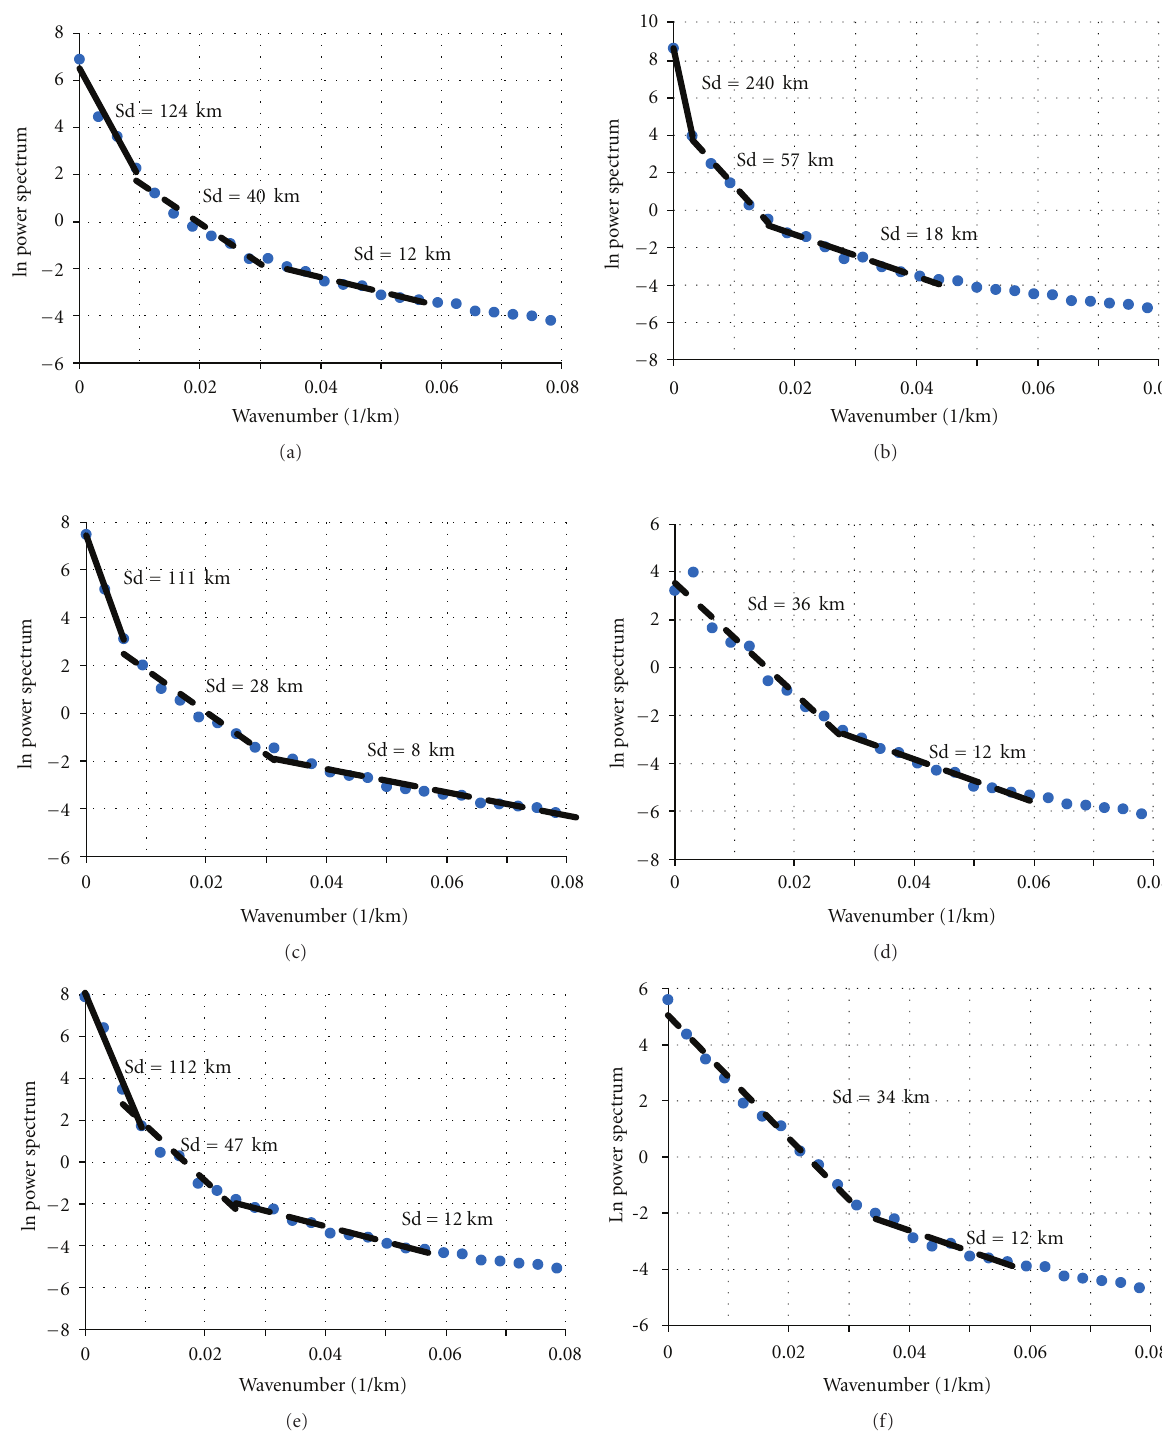
Figure 6: Results for the power spectrum analysis of the Bouguer gravity field using 2D fast Fourier transform. Black lines represent the trends of the linear regression separating the spectrum of mass points (blue points) located at a maximum estimated depth: (a) Barinas- Apure basin, (b) M´erida Andes, (c) Maracaibo basin, (d) Gu´arico basin, (e) Eastern basin, and (f) Leeward Antilles. Estimated depth